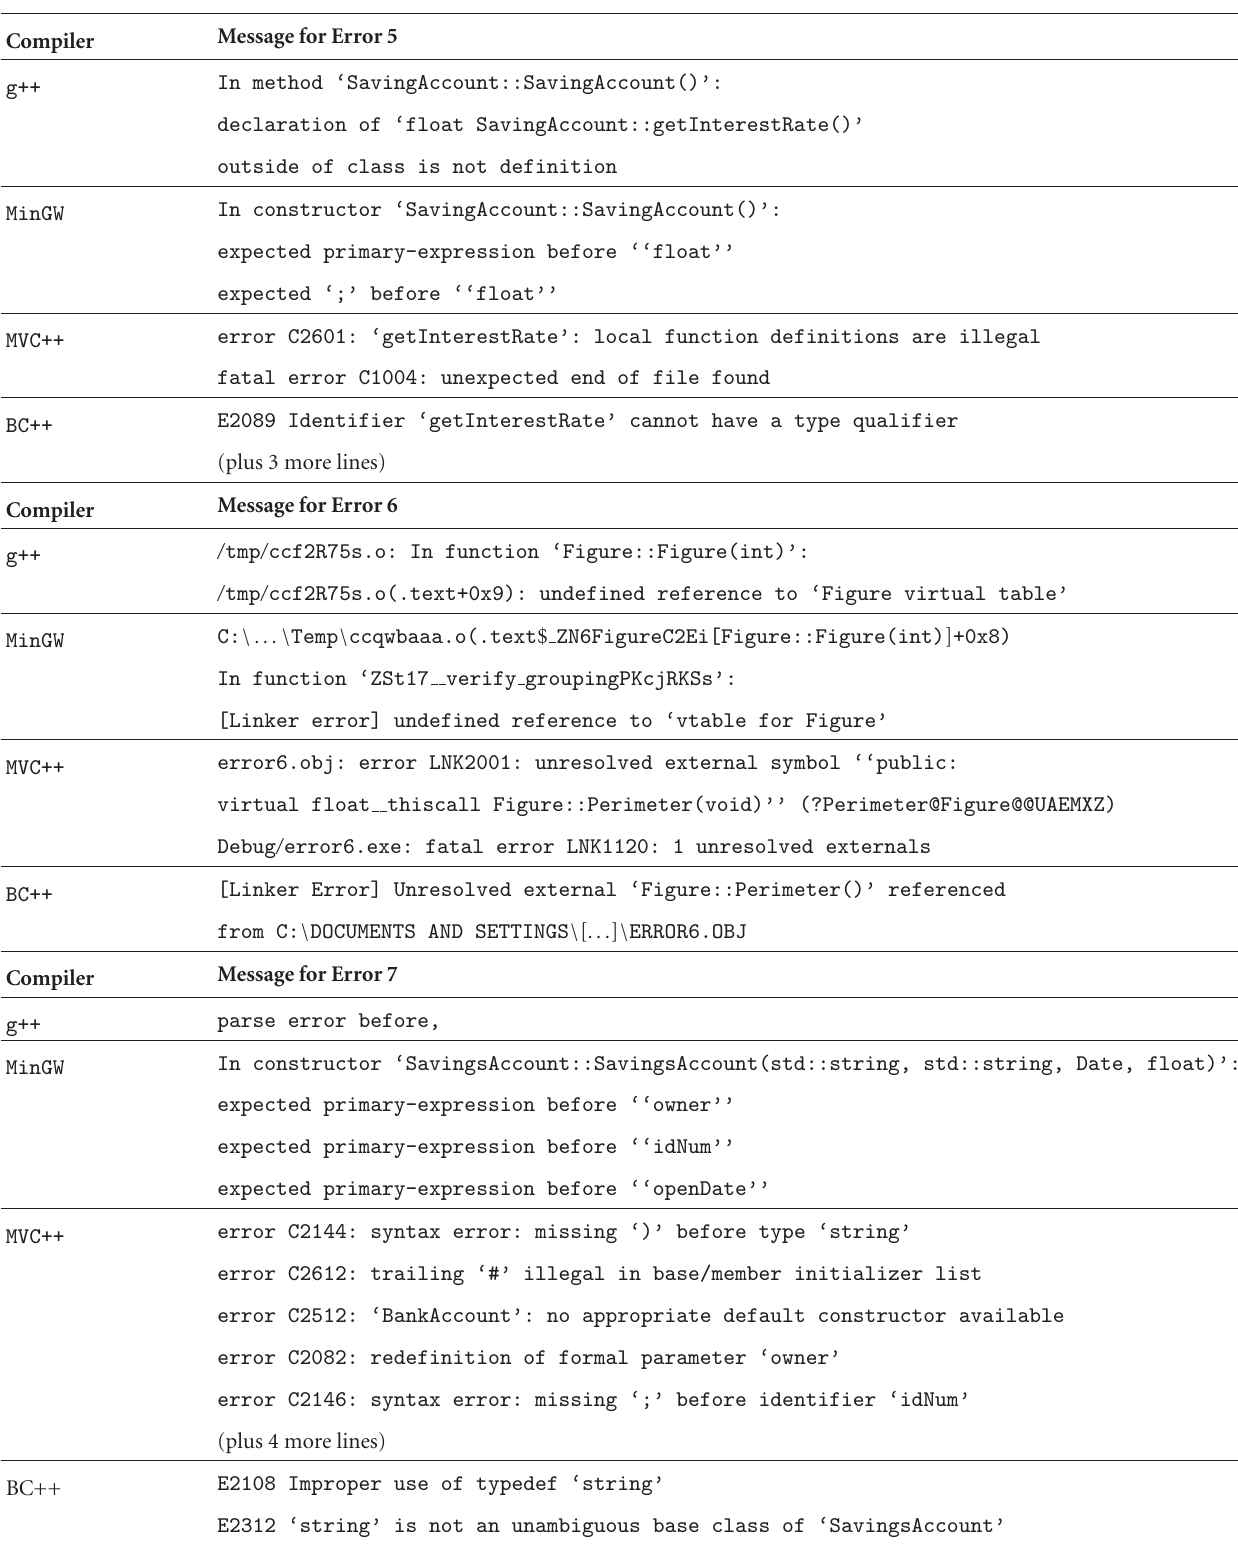
Table 4: Error messages of four di ff erent C++ compilers for Errors